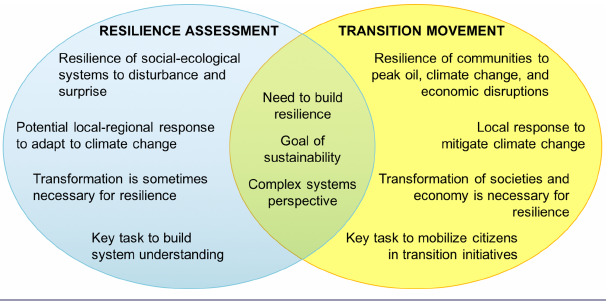
Fig. 3 . Key commonalities and differences. Derived from a qualitative text analysis between the Resilience Assessment’s and the Transition Movement’s respective written guidelines. See detailed table in Appendix